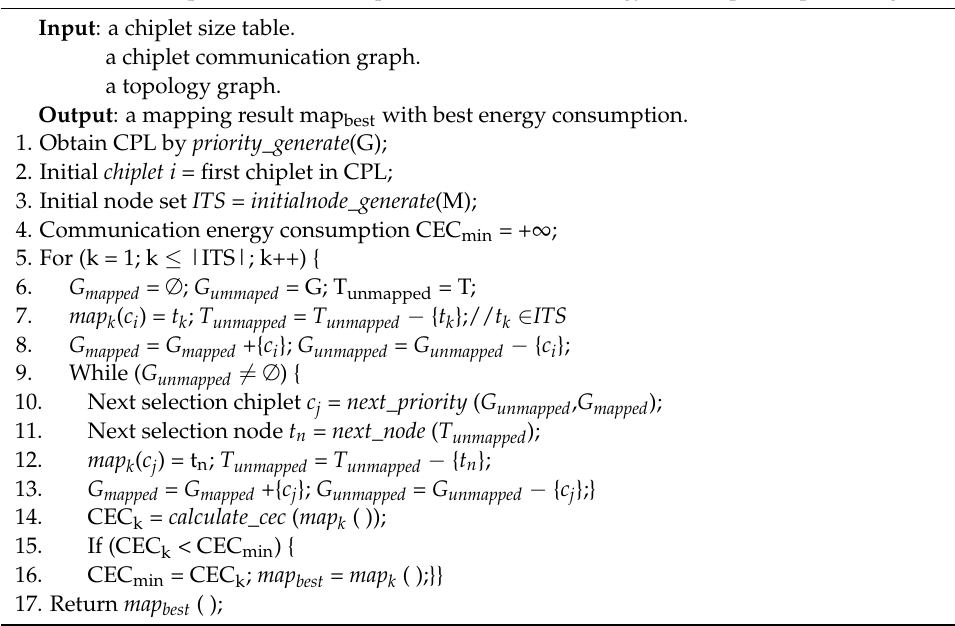
Algorithm 1 The pseudo-code of chiplet communication energy consumption optimal